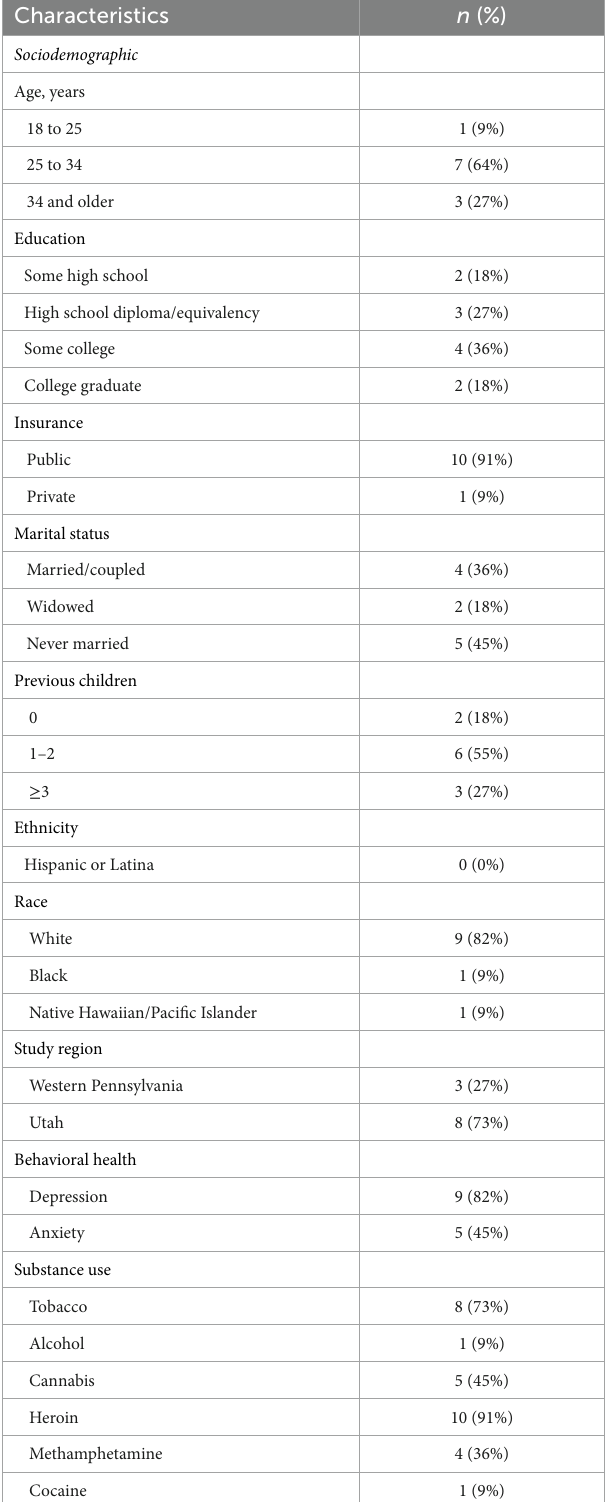
TABLE 2 Characteristics of the